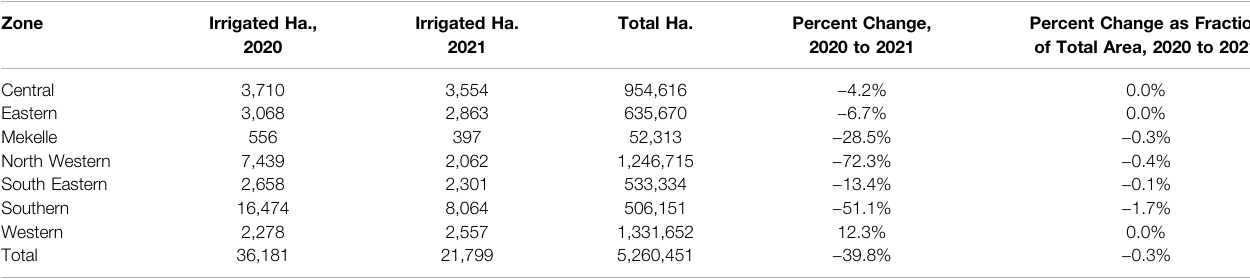
TABLE 2 | Predicted irrigated area statistics in Tigray for 2020 and 2021, organized by zone. Zone Irrigated Ha.,